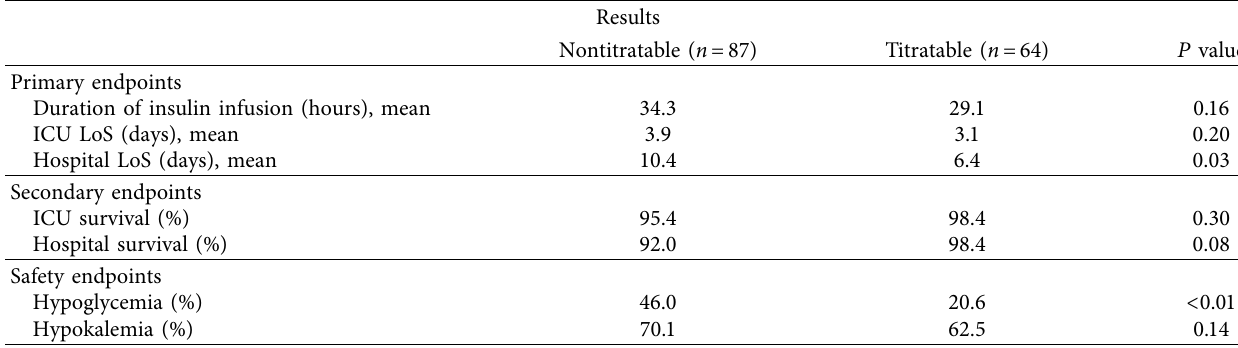
Table 2: Titratable vs. nontitratable insulin infusion patients.